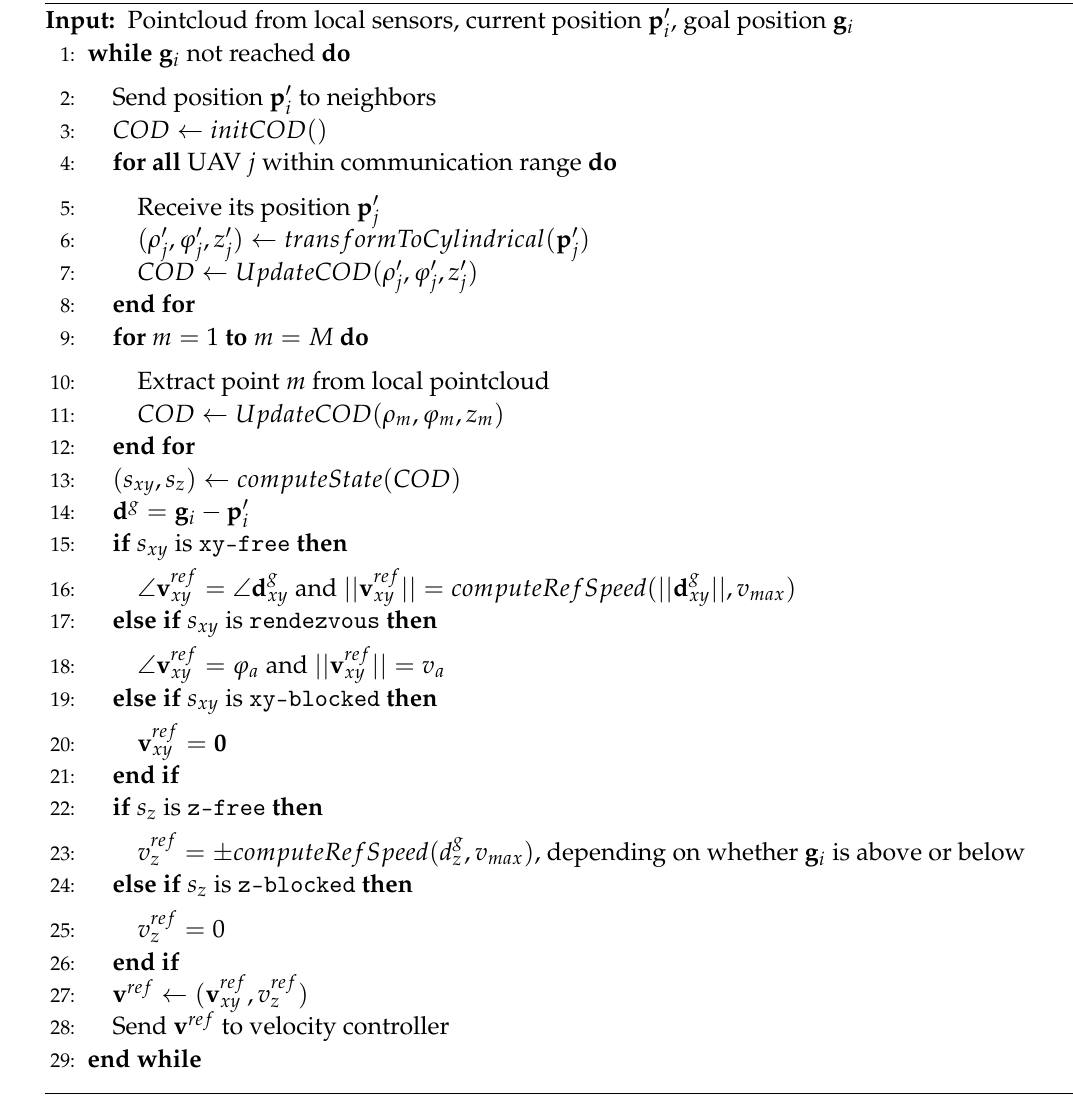
Algorithm 1 3D-SWAP for each UAV